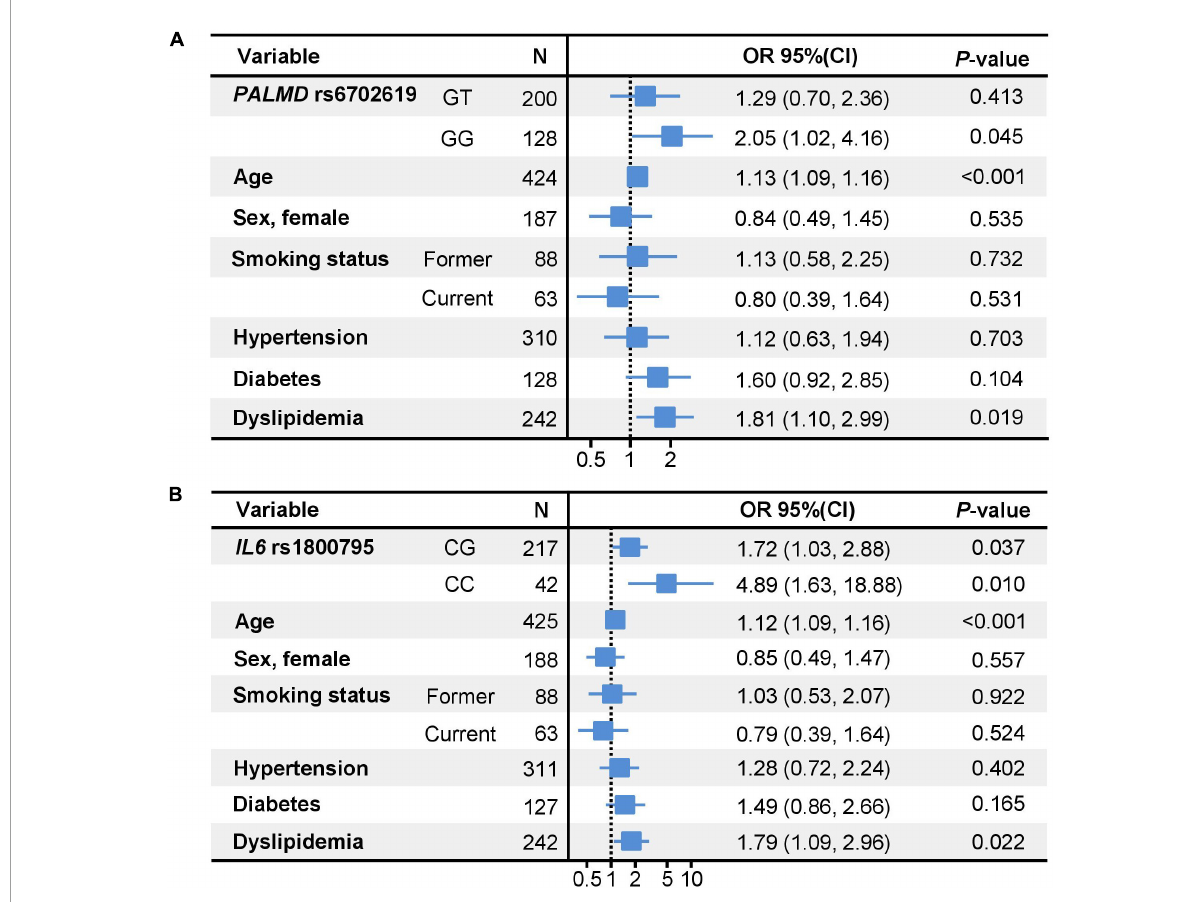
All ( n = 578) (70% aortic TAV ( n = 429) (74% stenosis) aortic stenosis)